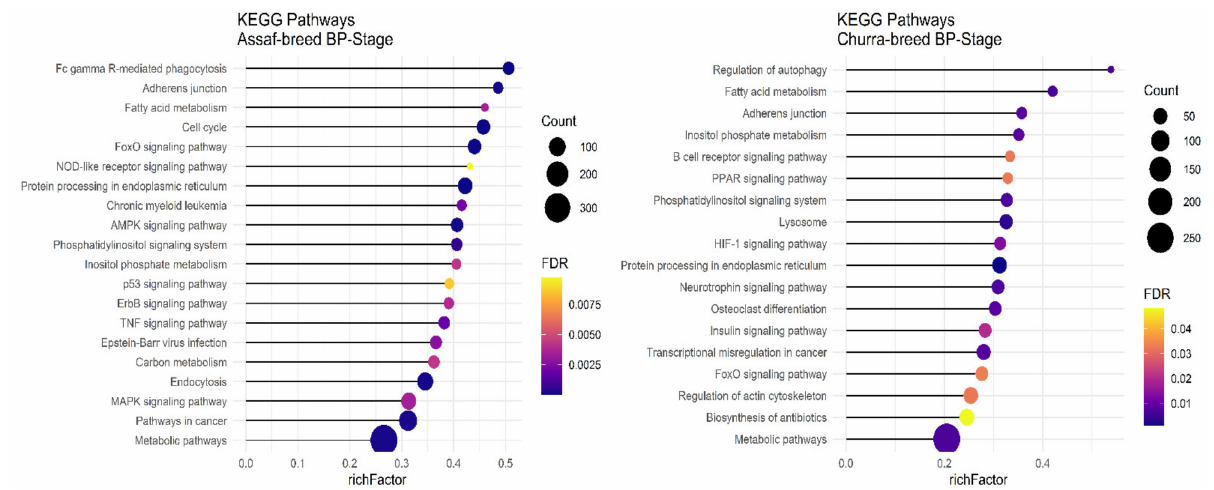
Figure 7. Functional enrichment analysis results of BP stage in Assaf and Churra sheep breeds. Since the significant KEGG pathways term is large, only 20 top significant terms are shown. The color and size of points indicate FDR and the number of genes associated with each term,